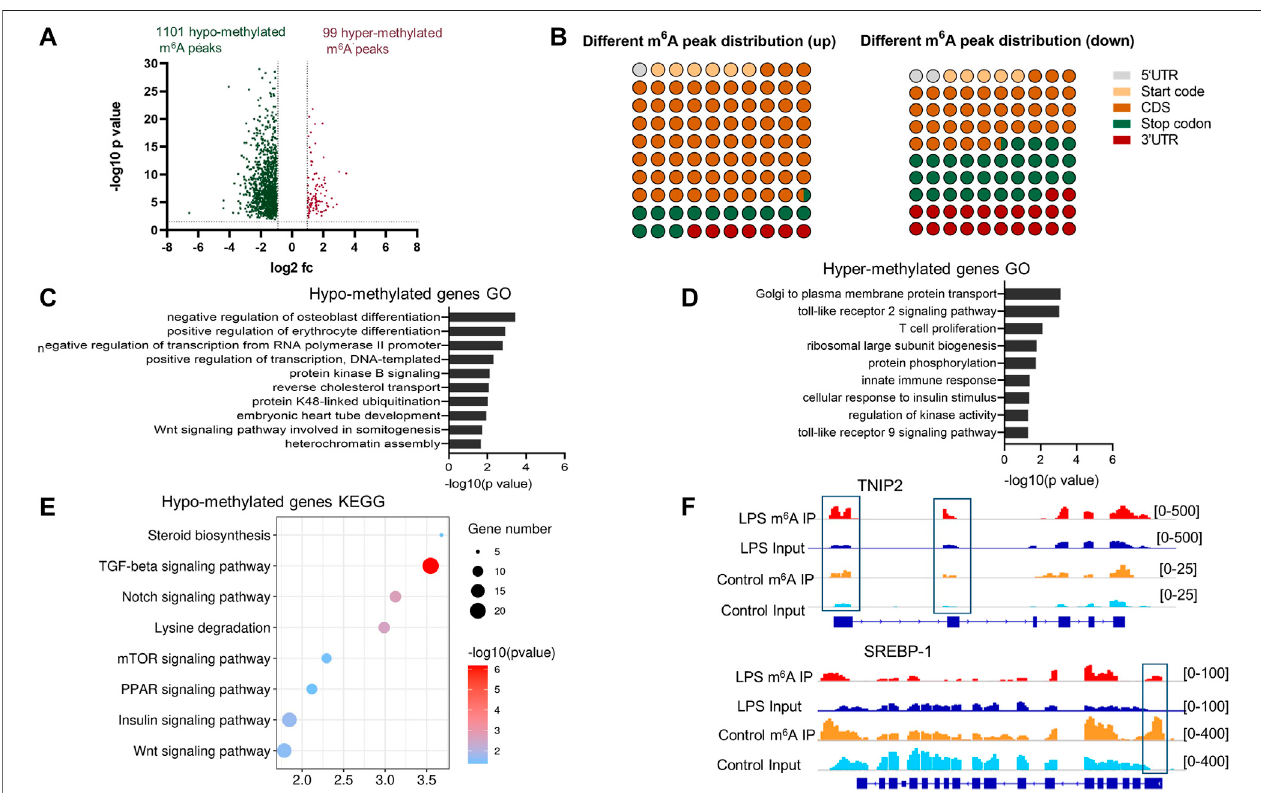
FIGURE 3 | Global m 6 A modi fi cation changes in liver of LPS-treated group compared with normal group. (A) Hyper-methylated and hypo-methylated m 6 A peaks identi fi ed in the LPS group (fold change > 2, p < 0.05). (B) The distribution of the differentially methylated peaks along the transcripts. (C,D) Gene ontology analysis of biological process of the transcripts with hypo-methylated m 6 A peaks and hyper-methylated m 6 A peaks, respectively. The enriched GO terms were shown in columns with − log10( p -value)indicatingthesigni fi cance. (E) Genesetenrichmentpathwayanalysisoftranscriptswithhypo-methylatedm 6 ApeaksinLPS-treatedsamples. (F) Them 6 AabundancesinTNIP2and SREBP-1mRNAtranscriptsinControland LPSsamples,asdetectedbym 6 A-seq.Theblue rectanglesindicatedthem 6 Apeaks that have a signi fi cant increased or decreased abundance (fold change > 2, p < 0.05) in LPS samples comparing with the Control